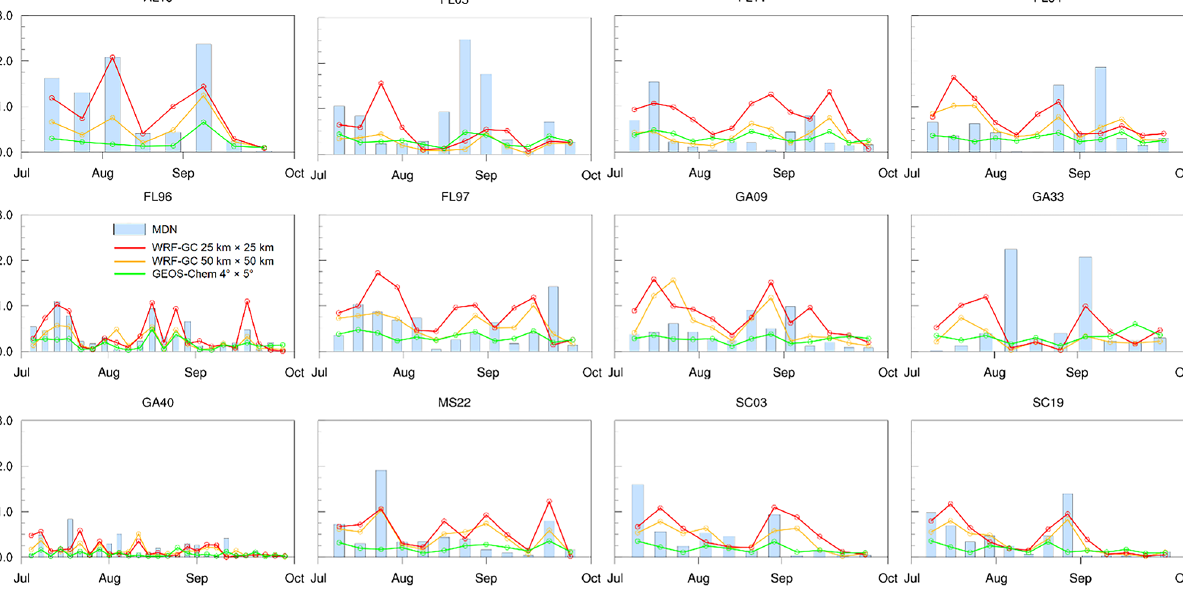
Figure 6. Time series plot of comparison of MDN observation, GEOS-Chem 4 ◦ × 5 ◦ , and WRF-GC 50km × 50km and 25km × 25km simulation results. This plot only shows MDN sites in Florida; a full time series plots is found in the